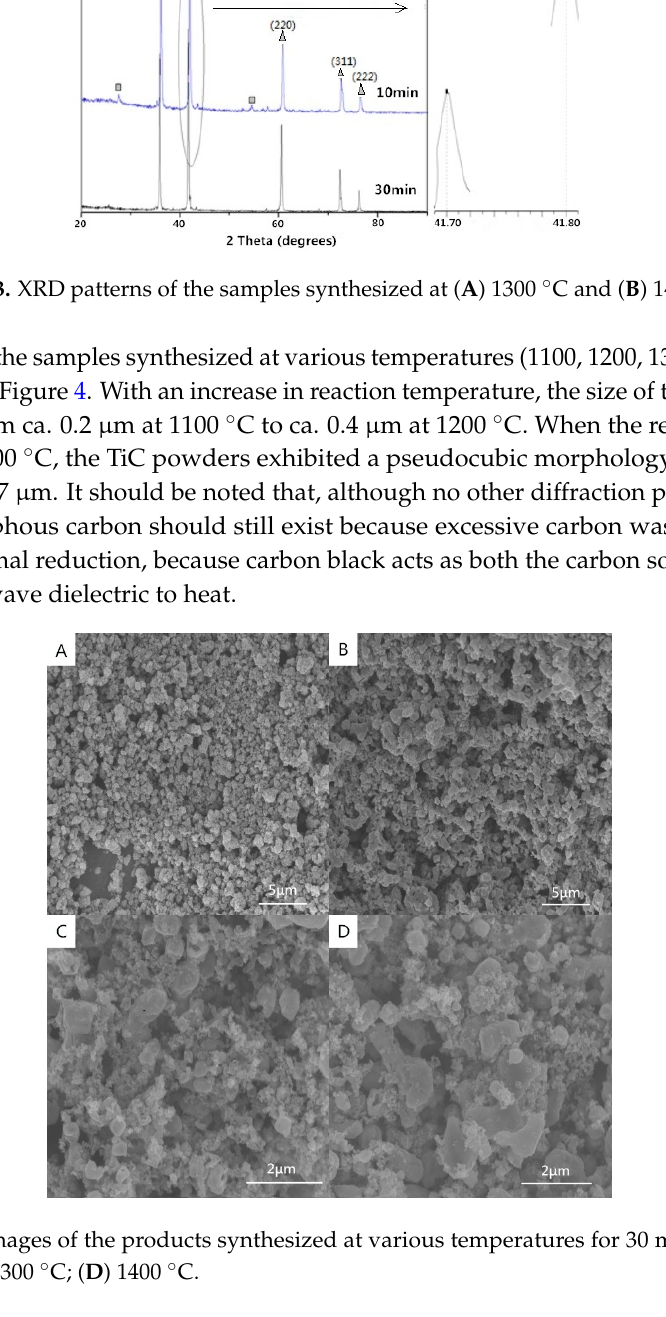
Figure 4. SEM images of the products synthesized at various temperatures for 30 min: ( A ) 1100 °C; ( B ) 1200 °C; ( C ) 1300 °C; ( D ) 1400 °C.